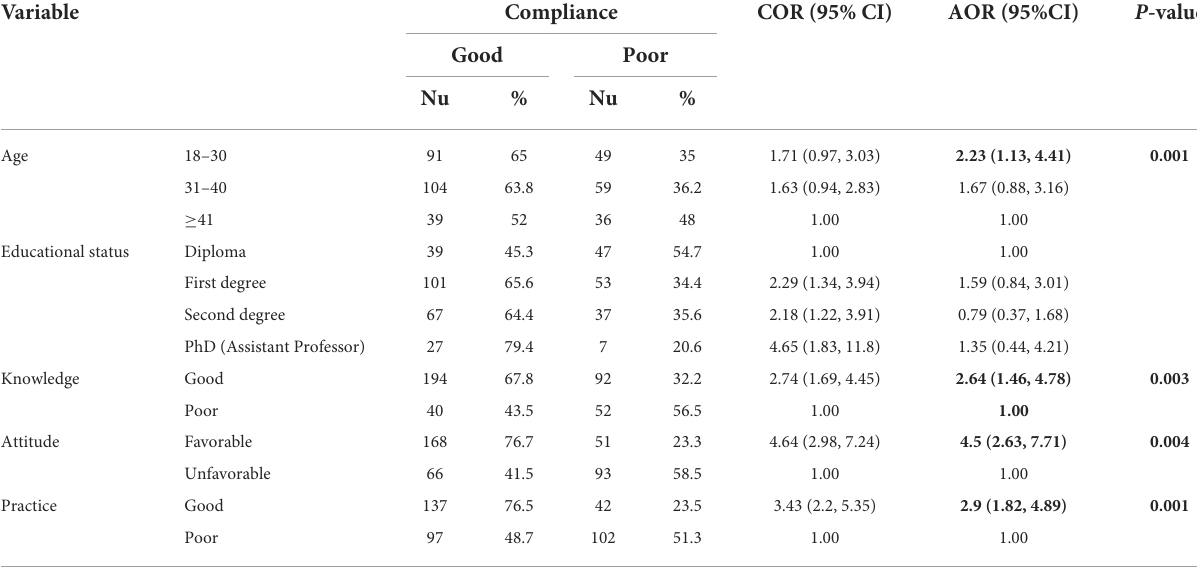
TABLE 3 Bivariate and multivariate logistic regression of factors affecting respondents’ compliance toward COVID-19 preventive measure among the Ambo University community, 2022, ( n = 378).